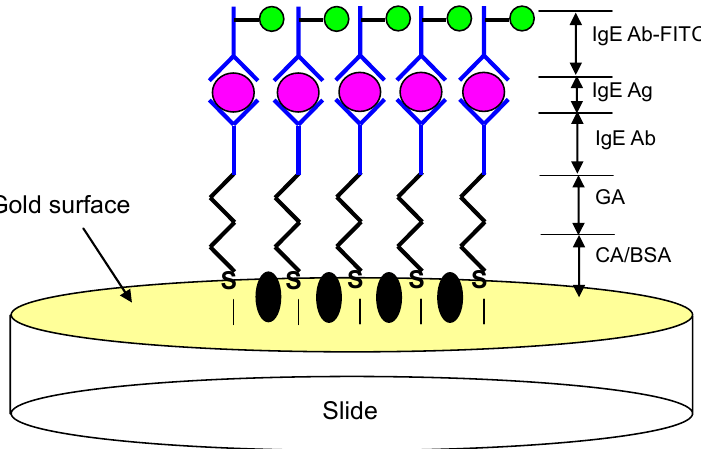
Figure 6. Schematic diagram of the integration of cystamine, glutaraldehyde, IgE antibody/antigen, and IgE antibody-FITC on the slide.